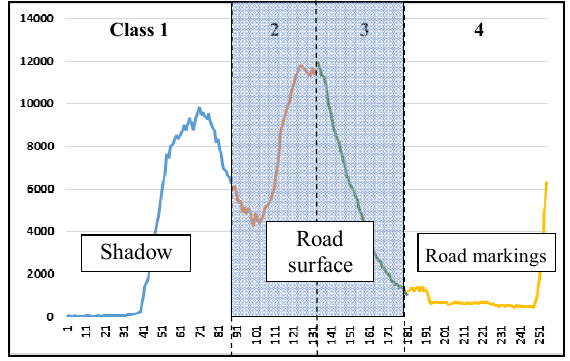
Figure 9. 4-classed by OTSU algorithm